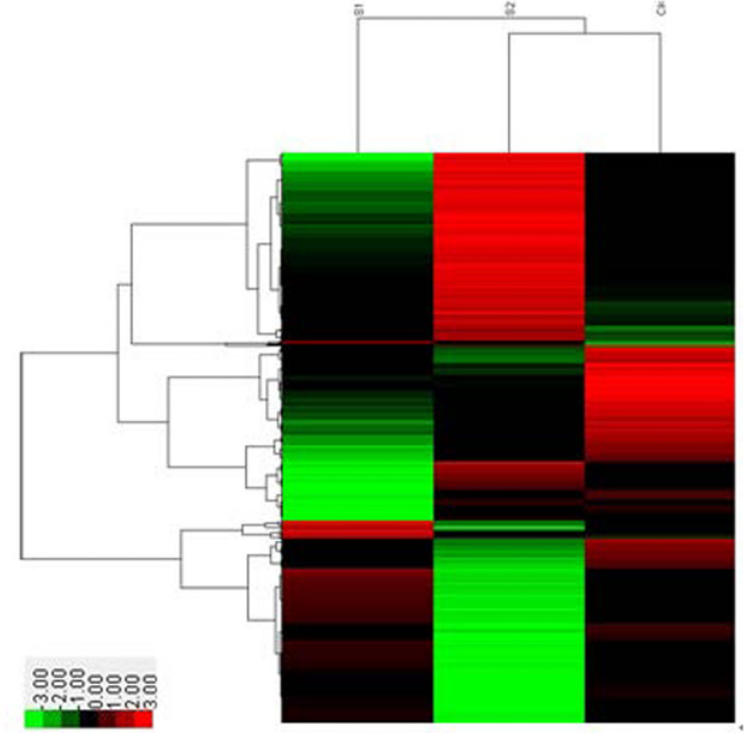
Fig 8. Cluster analysis of the expressed genes. Every column stands for a sample and each line represents a single gene. Different colors indicate different expression levels. Red indicates up-regulation and green indicates down-regulation, while the black indicates